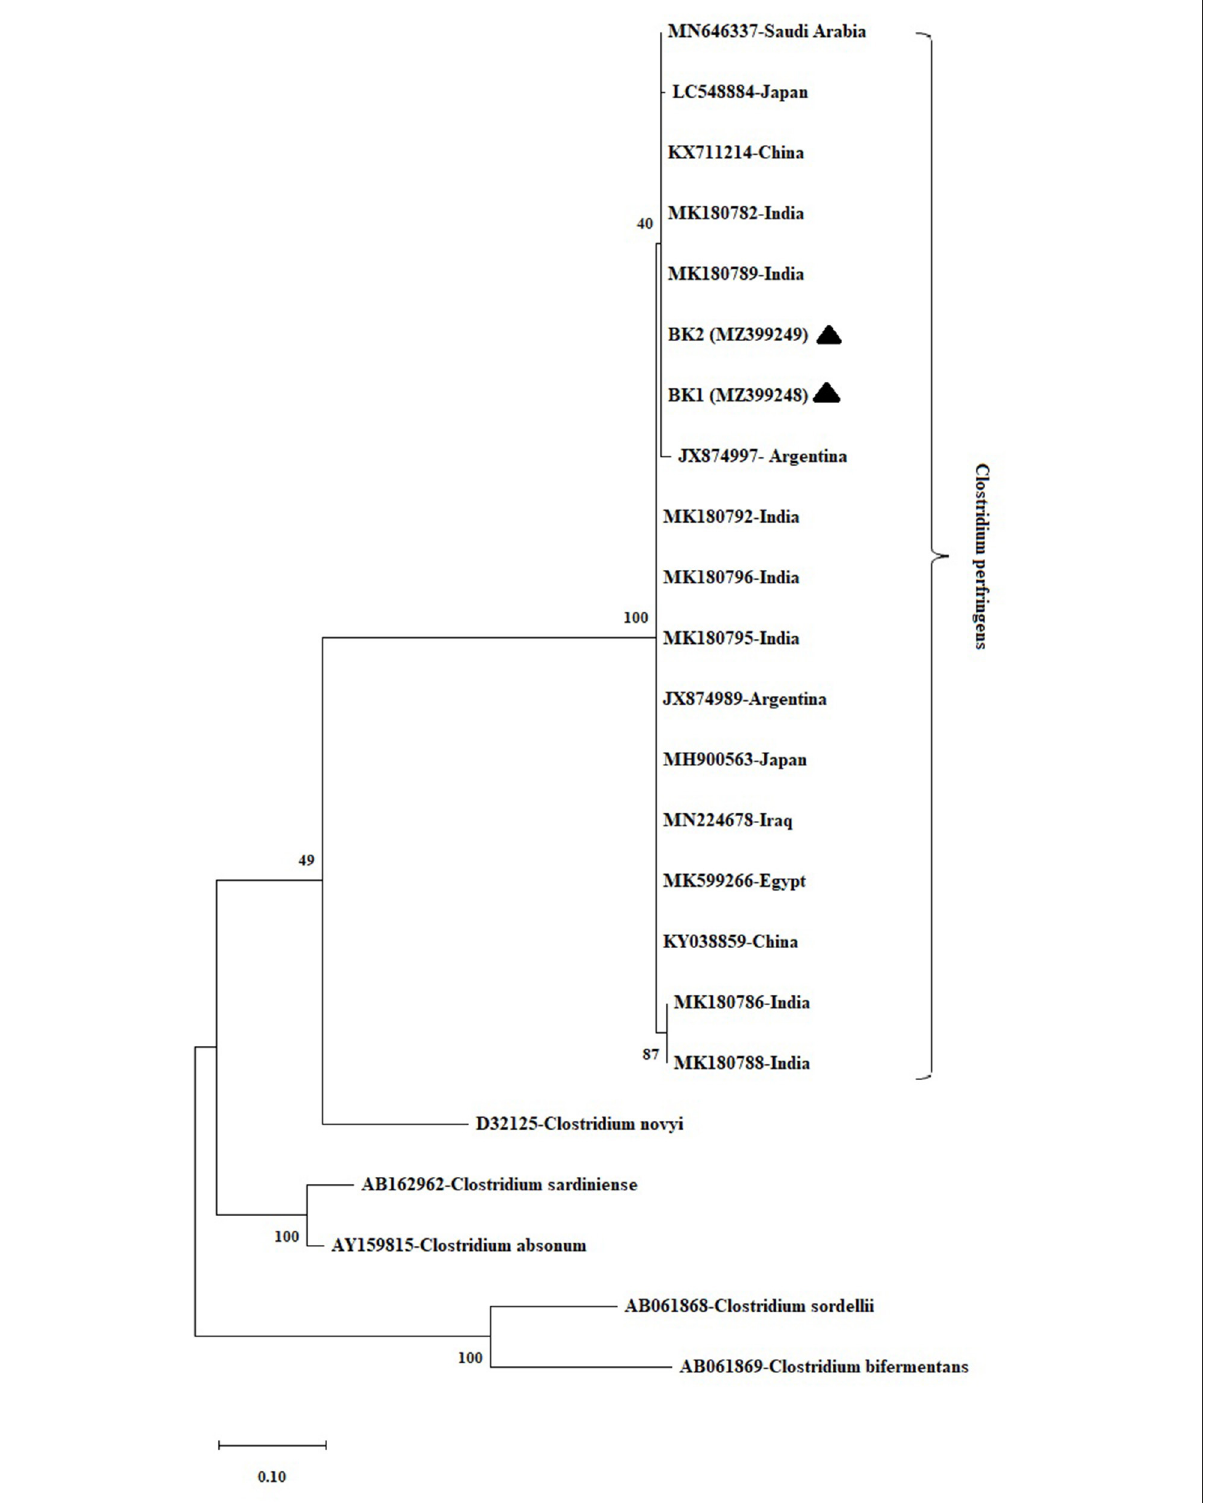
FIGURE2 Phylogenetic tree of Clostridium perfringens samples ( n = 2) detected in adult Fasciola spp, based on a 210 bp long fragment of the Cpa gene. C. sardiniense (AB162962), C. novyi (D32125), C. absonum (AY159815), C. sordellii (AB061868), and C. bifermentans (AB061869) were used as outgroup sequences for phylogenetic tree construction. MEGA X was used to construct a Maximum Likelihood tree based on the T92 + I model. The reliability of the tree was assessed by 1,000 bootstrap replications. Fasciola spp . samples (MZ399248, BK1; MZ399249, BK2) are indicated by black